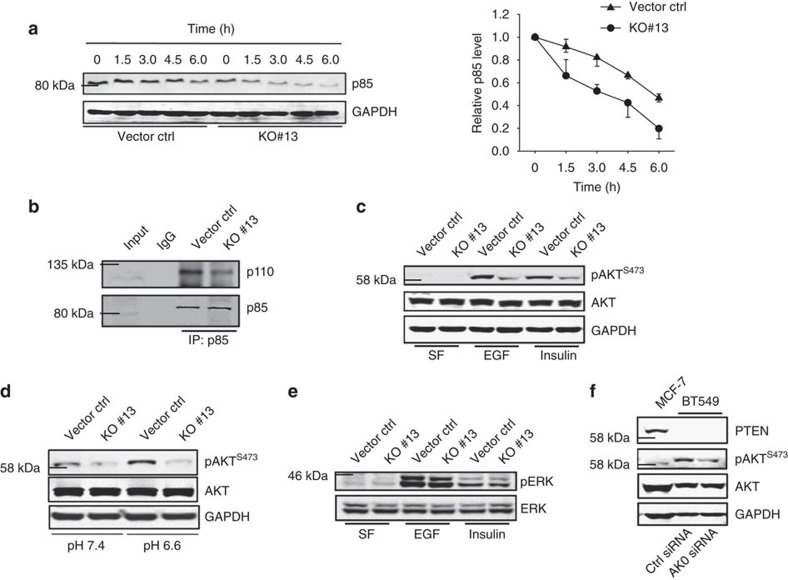
AK023948 has an impact on the p85 stability.(a) Effect of AK023948 KO on the p85 stability. MCF-7 cells were treated with cycloheximide (CHX) at 20 μg ml−1 and then were harvested for western blot at indicated time points. Half-life curve is on the right. (b) AK023948 KO reduces the interaction of p85 with p110, as detected by co-IP. (c) AK023948 KO inhibits the growth factor-induced AKT activation. Cells were first cultured in a serum-free medium for 2 h and then EGF or insulin was added at 10 ng ml−1 for 30 min. (d) AK023948 KO inhibits the acidosis-induced AKT activation. Cells were cultured at pH 7.4 or pH 6.6 for 2 h before harvesting for western blot. (e) AK023948 KO has no effect on ERK activity. Cells were treated with the same way as in c. (f) Suppression of AK023948 by RNAi can still reduce the pAKT level in PTEN-deficient BT549 cells.